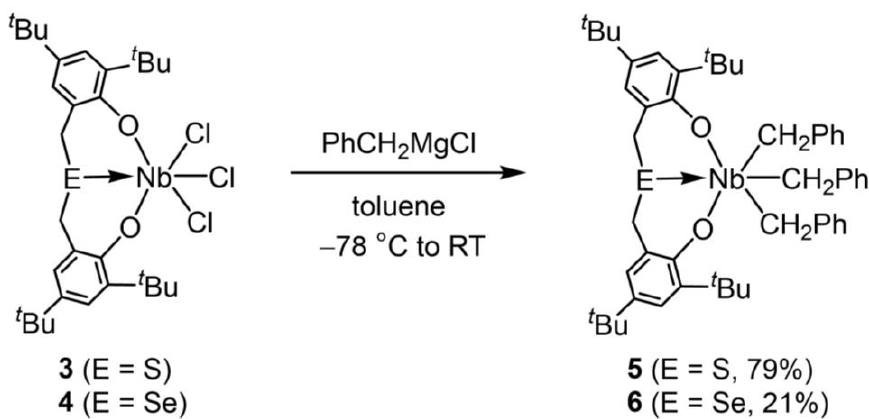
− 78 °C in toluene to afford the corresponding tribenzyl niobium(V) complexes 5 and 6 in the form of orange crystals in 79 and 21% yields, respectively (Scheme 3).